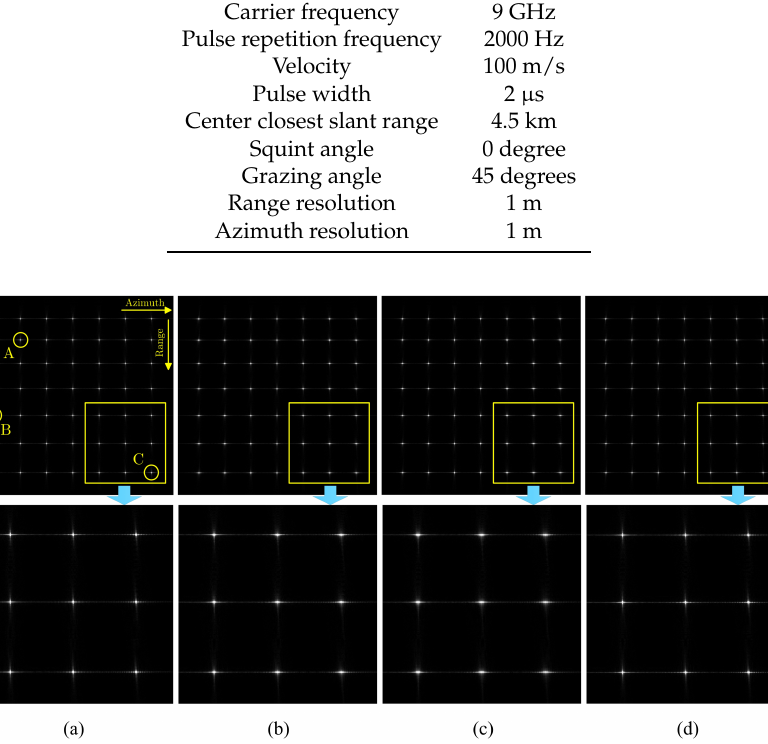
Figure 6. X-band point target simulation and magnified sub-scene. ( a ) Ideal point image. ( b ) Azimuth-variant error interfered image. ( c ) Processed with conventional MDA. ( d ) Processed with AVMDA.